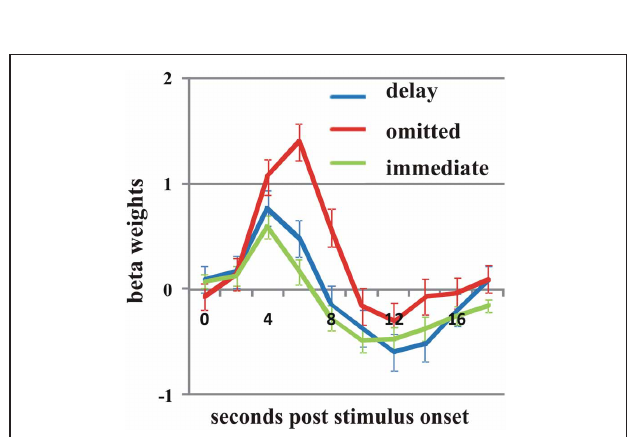
FIGURE 4 | In both participants who did not notice the delay, omitted feedback (red line) elicited a significantly stronger BOLD response in the posterior medial frontal cortex than delayed feedback (blue line) as well as immediate feedback (green line) ( t = 3; p < 0 . 003). Error bars indicate